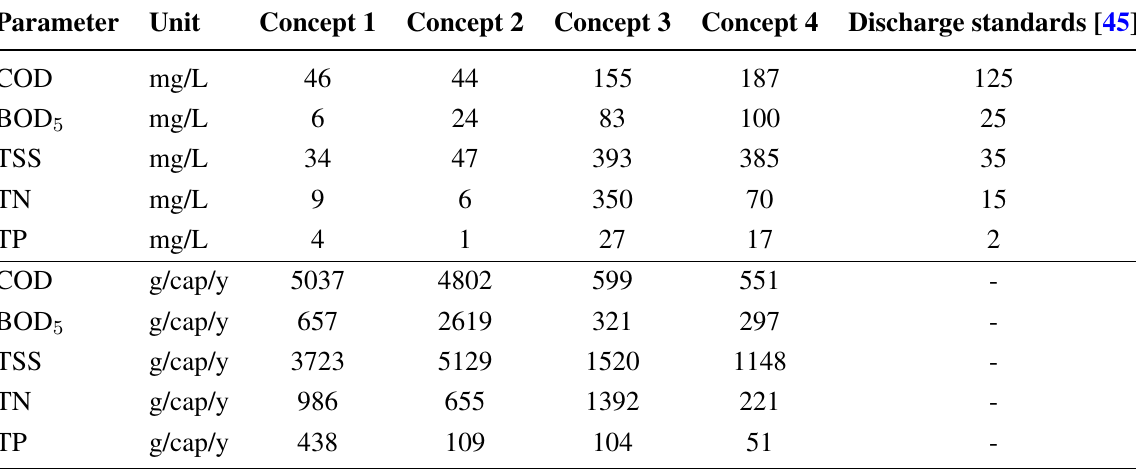
Table 5. Calculated effluent quality in sanitation concepts and discharge